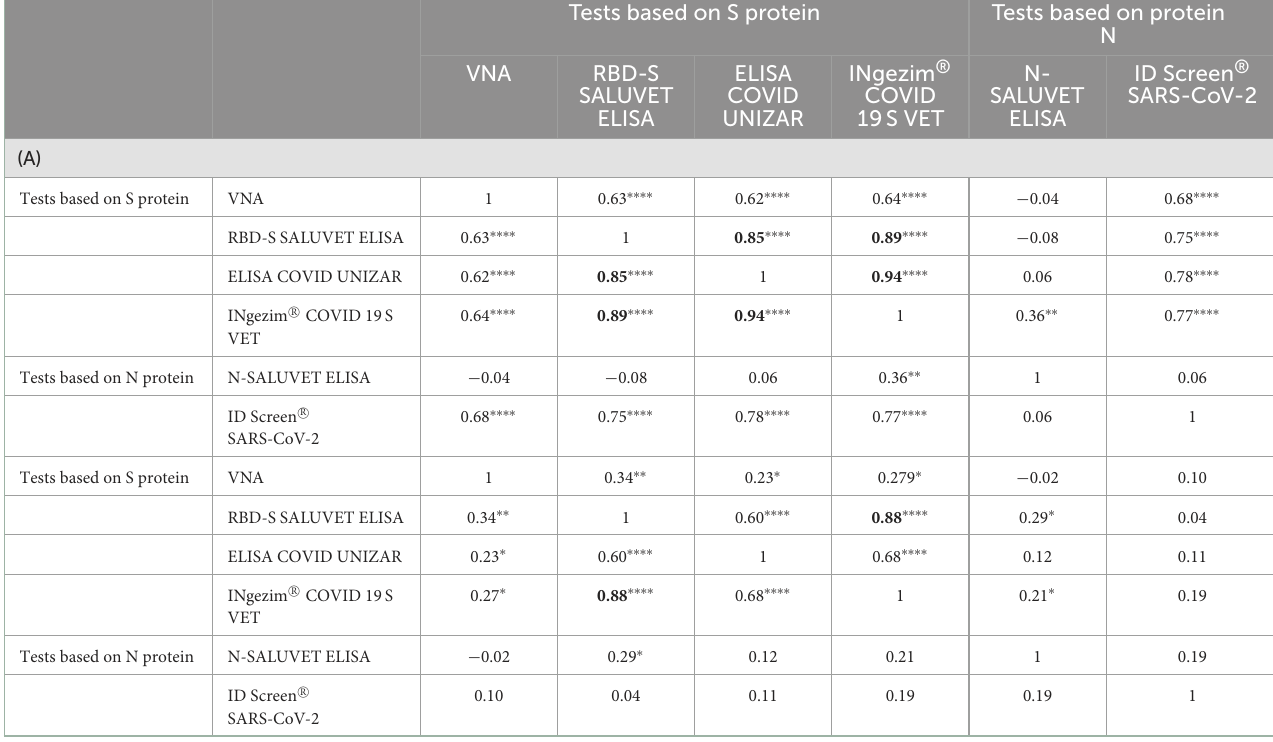
TABLE 4 Correlation coefficients (Pearson r ) between quantitative serological techniques for cats (A) and dogs (B). Tests based on S